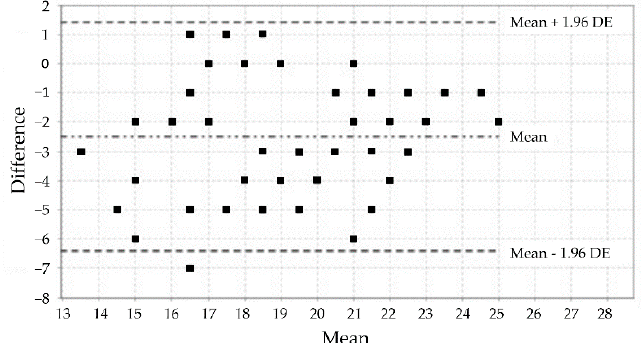
Figure 3. Bland–Altman plot of the kinesthetic subscale of the MIQ-3. 3.4. Analysis of Differences in MI Ability as Measured by the MIQ-3 concerning Sex and Age The mixed factorial ANOVA indicated in the case of the comparison according to sex in the three subscales, i.e., internal visual, external visual, and kinesthetic, that there was no significant interaction between the within-subjects factor (the two measurements taken) and the between-subjects factor (sex). There was also no significant effect of the inter-subject factor, but there was a significant effect of the intra-subject factor. Both sexes behaved similarly, with significantly higher values in the second session than in the first session. There were no differences between males and females in either measurement (Table 4). Table 4. The mixed factorial analysis of variance (ANOVA) results of the differences in motor imagery (MI) ability measured through the MIQ-3, according to sex. Inter-Subject Factor